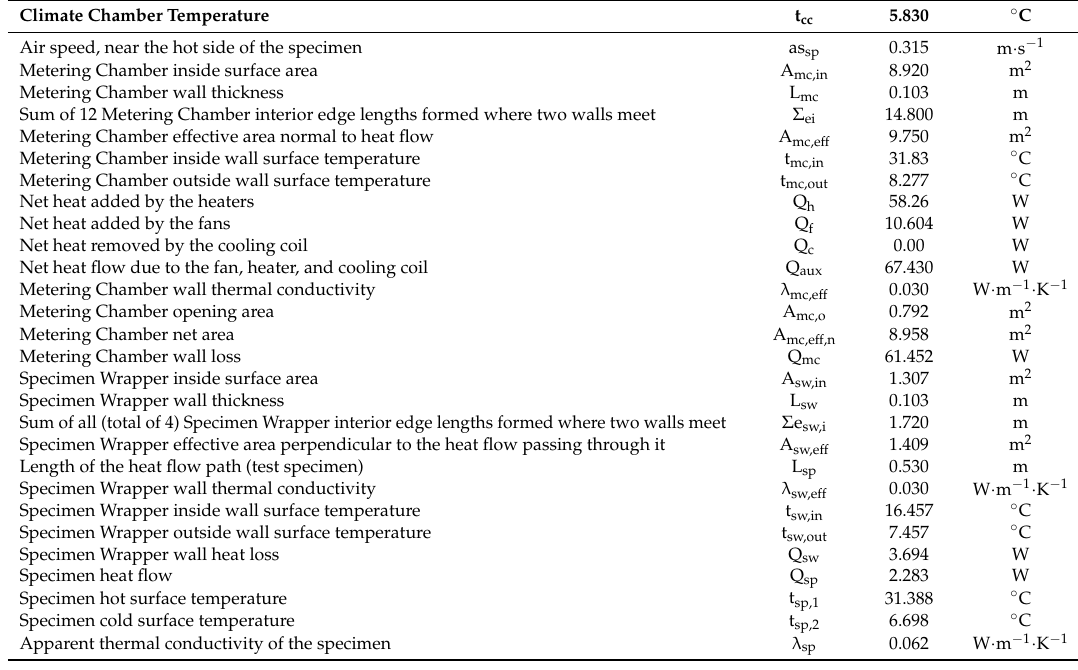
Table 7. Calculation of the thermal conductivity of the specimen